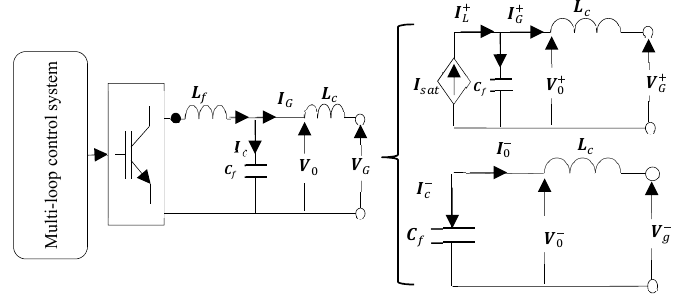
Figure 6. Equivalent sequence circuits of the inverter during current limiting operation.